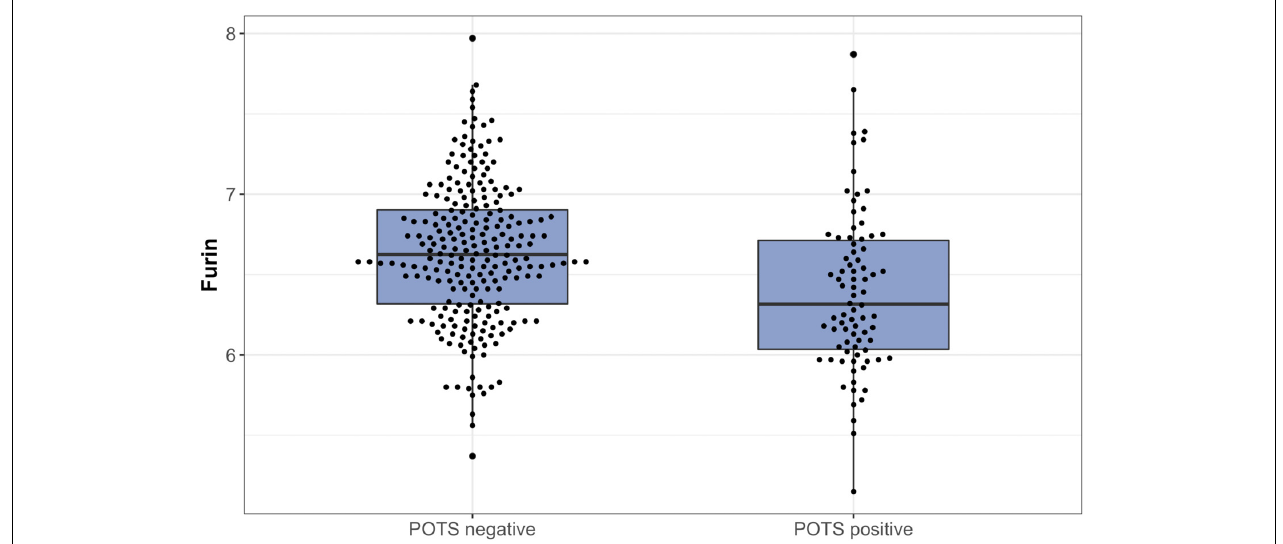
FIGURE 1 | The plasma levels of proconvertase furin, expressed on a log2 scale, presented in relation to POTS status. Data are shown as a box and whisker plot with median in the box and the whiskers representing the 5th and 95th percentiles in relation to plasmatic biomarker levels.